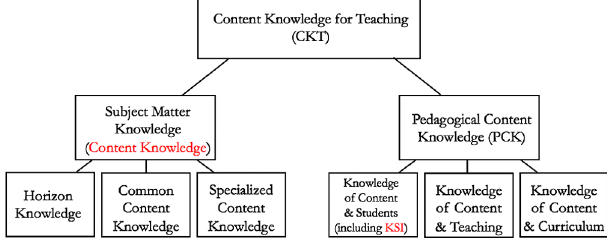
FIG. 2. Example from Ball and Bass [3].